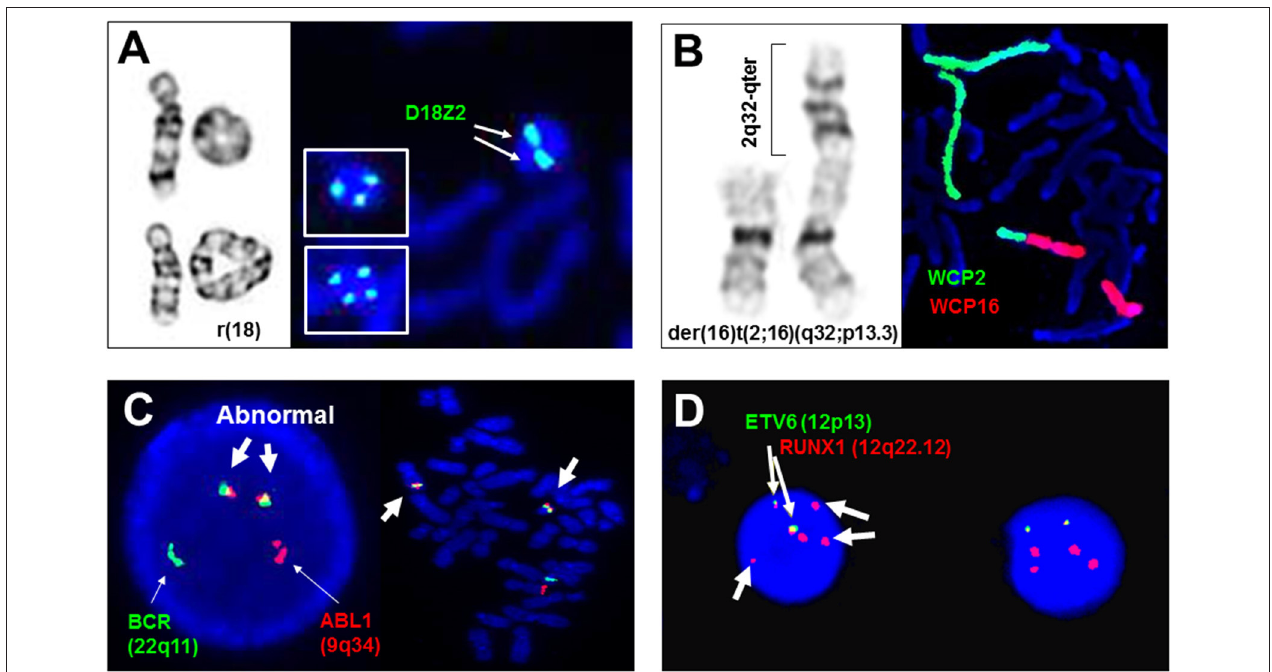
FIGURE 1 | Adjunctive and diagnostic assays of FISH in clinical cytogenetics. (A) The detection of di-centric, tri-centric, and tetra-centric ring chromosome 18 using a centromeric probe D18Z2 for chromosome 18. Left panel shows normal chromosome 18, dicentric ring 18 in top, and tetracentric ring 18 in bottom, right panel shows dicentric ring 18 and tricentric/tetracentric ring 18 in insets by FISH. (B) The detection of a derivative chromosome 16 from a 2q32/16p13.3 translocation by whole chromosome painting probes for chromosomes 2 (WCP2) and 16 (WCP16). (C) The detection of ABL1/BCR gene fusions in interphase and metaphase cells by dual color double fusion probes (thin arrows point to the normal signal and thick arrows point to the abnormal fusion signals). (D) Diagnostic use of ETV6 and RUNX1 probes for the detection of two fusion signals for a cryptic t(12;21)(p13;q22), loss of an ETV6 signal and gain of three extra RUNX1 signals (thin arrows point to the fusion signals and thick arrows to extra RUNX1 signals). All images are from Yale clinical cytogenetics